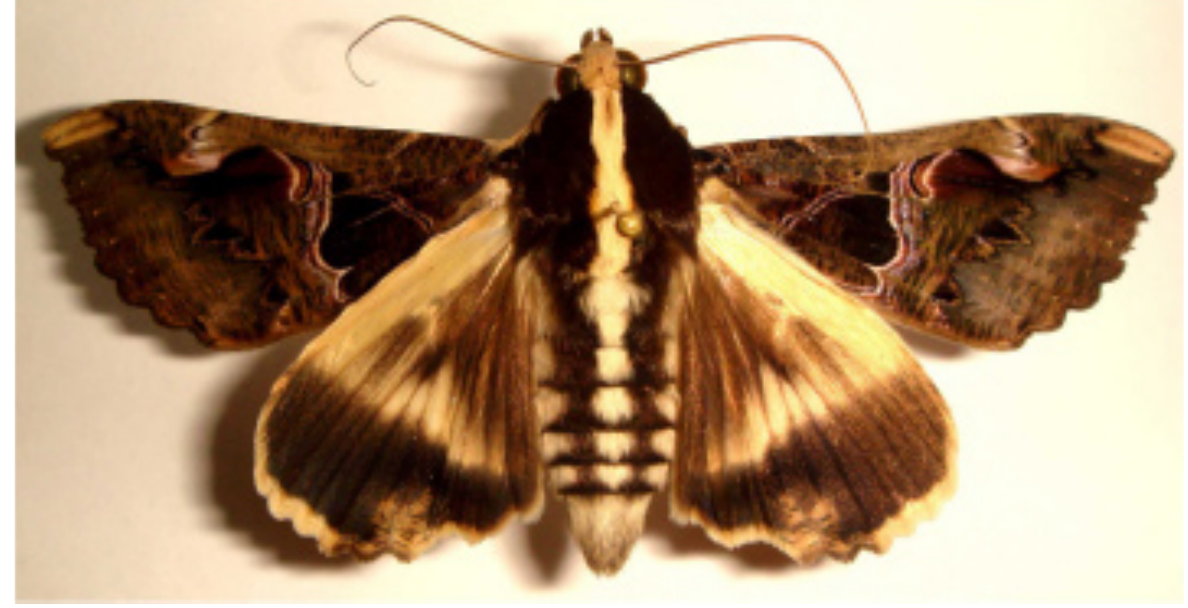
Image 3. Adult moth of Sphingomorpha chlorea